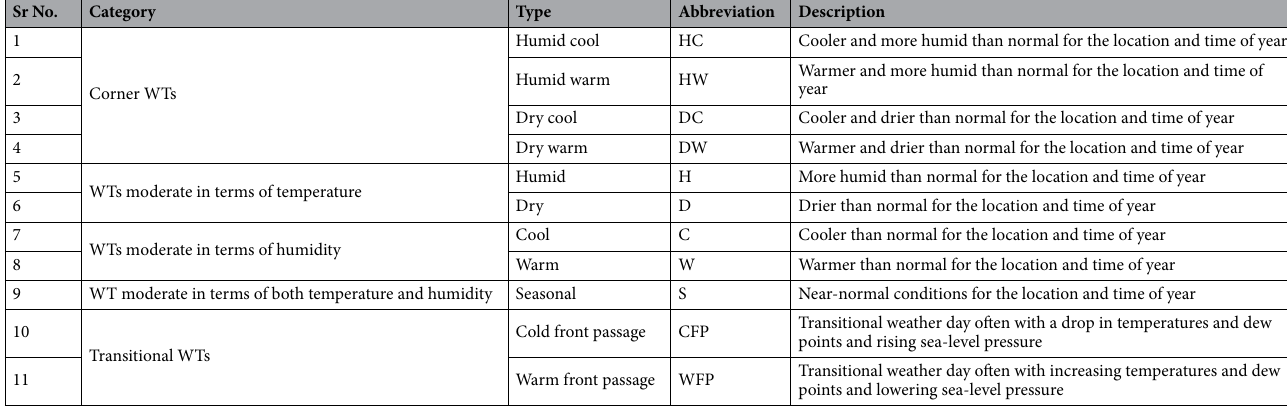
Table 2. Definition and characteristics of the WTs in GWTC.